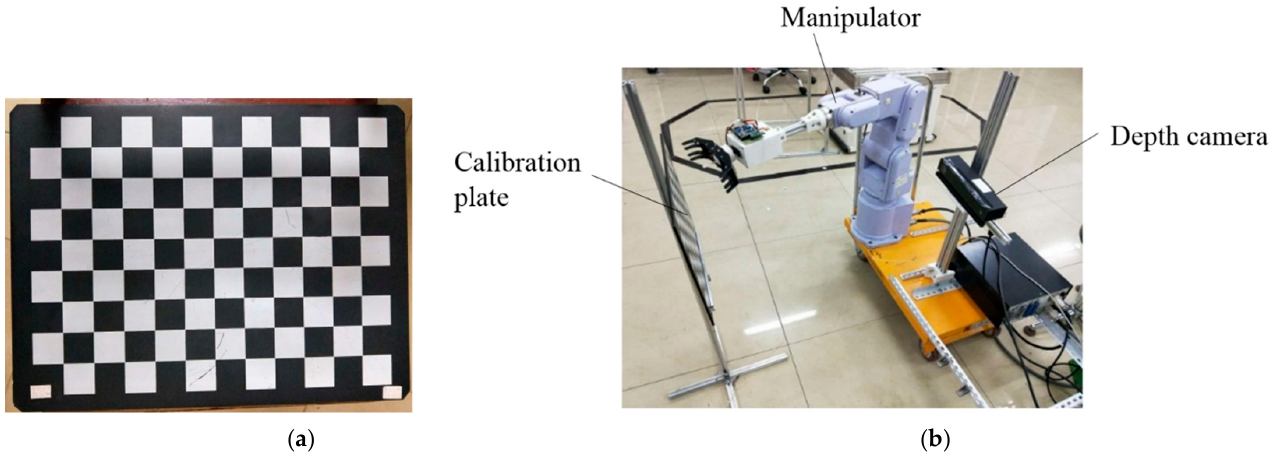
Figure 12. Depth Camera Calibration; ( a ) Calibration plate; ( b ) Depth camera.